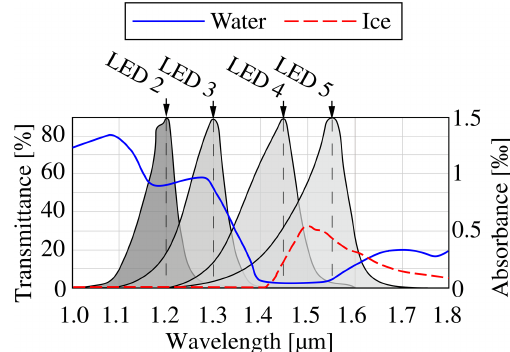
Figure 2. Infrared-based sensor system with five LEDs and one photodiode. Table 1. Characteristics of the five selected